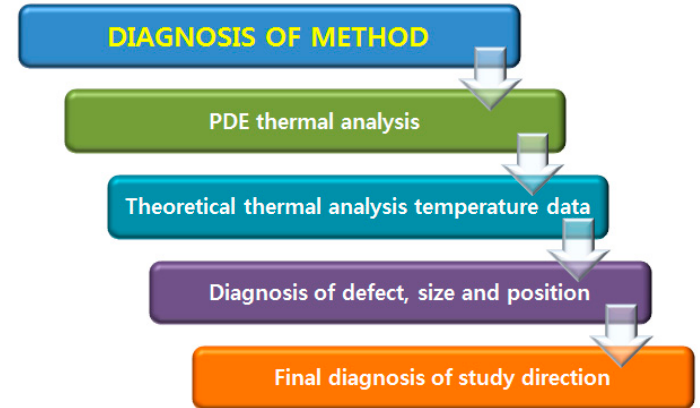
Figure 2. Flow chart of the study. PDE: partial differential equation.